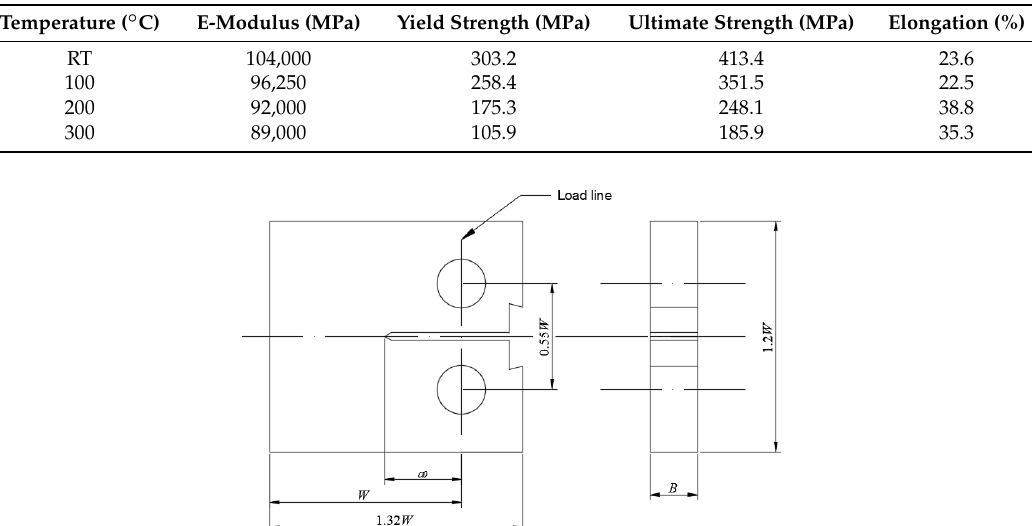
Figure 2. Schematic drawing of the standard compact tensile (CT) specimen. Table 2. Mechanical properties of CP-Ti. Metals 2018 , 8 , x FOR PEER REVIEW